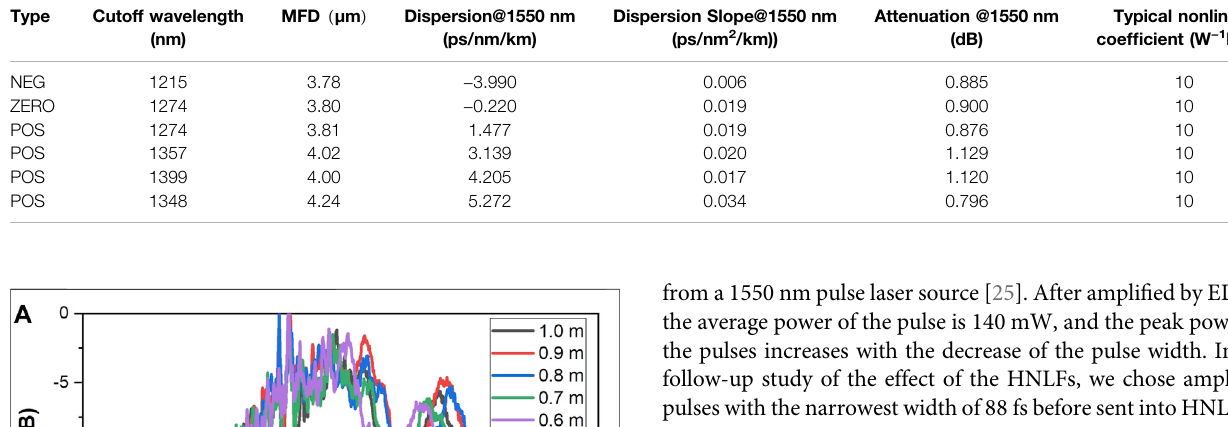
TABLE 1 | Parameters of the HNLFs used in the experiments.